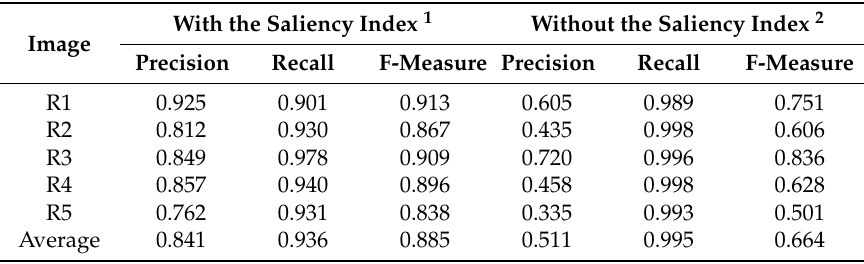
Table 5. The accuracy evaluation results of built-up areas